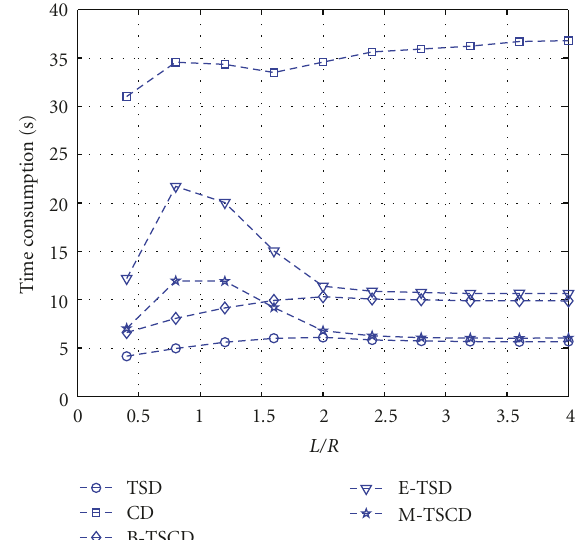
Figure 7: The e ff ect of step length on mobility-aided TSCD scheme.